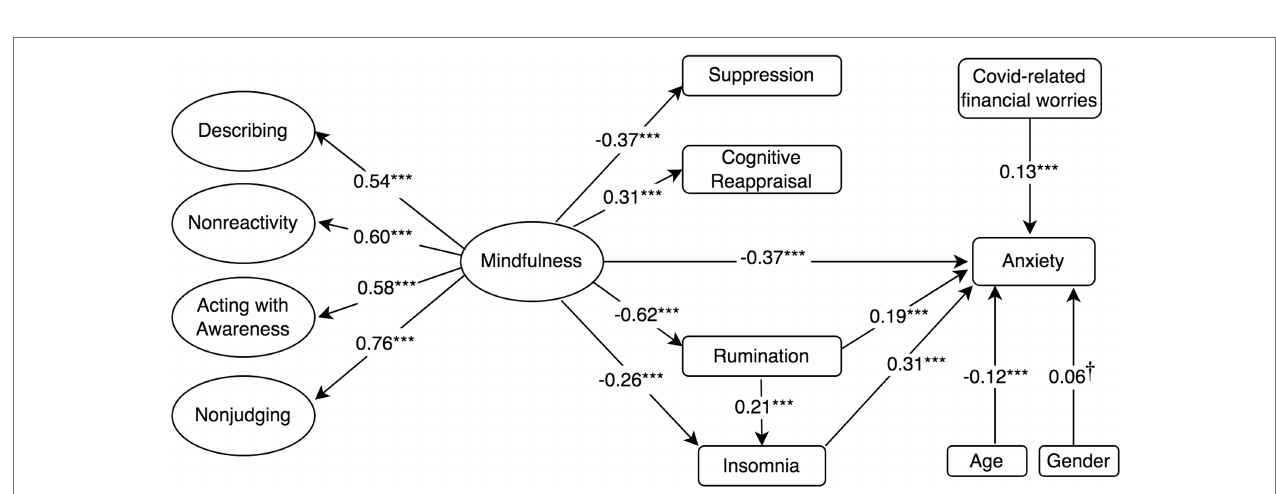
FIGURE 2 | Standardised mediation Model 2 of the effect of higher-order mindfulness on anxiety. Anxiety = GAD-7, a 7-item Generalised Anxiety Disorder; Rumination = RSS-SF, 10-item Rumination Response Scale-Short Form; Cognitive Reappraisal and Suppression = ERQ, 10-item Emotion Regulation Questionnaire; Insomnia = ISI, 7-item Insomnia Severity Index; and Mindfulness and facets = FFMQ-SF, 24-item Five-Facets Mindfulness Questionnaire-Short Form. † p < 0.10; * p < 0.05; ** p < 0.01; and *** p ≤